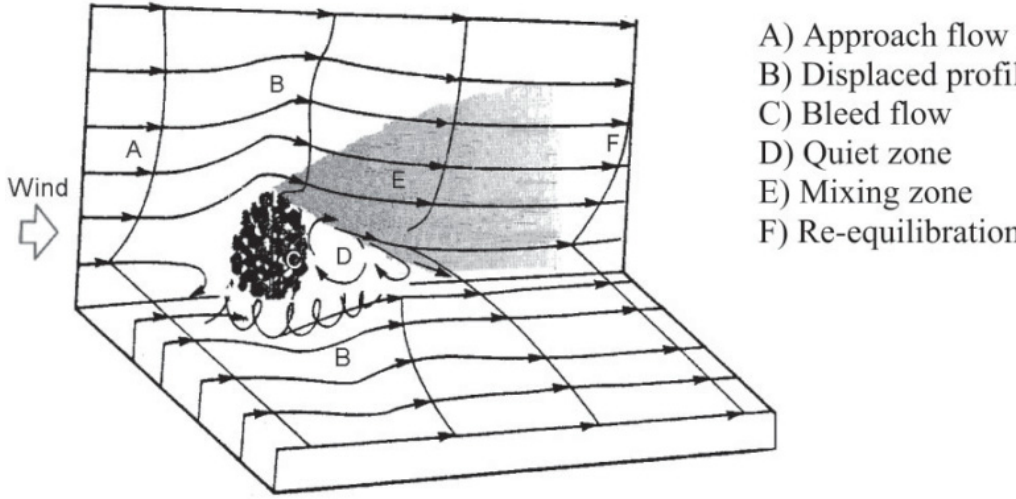
Figure 1. Flow visualisation around a single vegetation element, showing the development of six different flow regimes (from [46] (p. 1457), adapted from [43,44]).